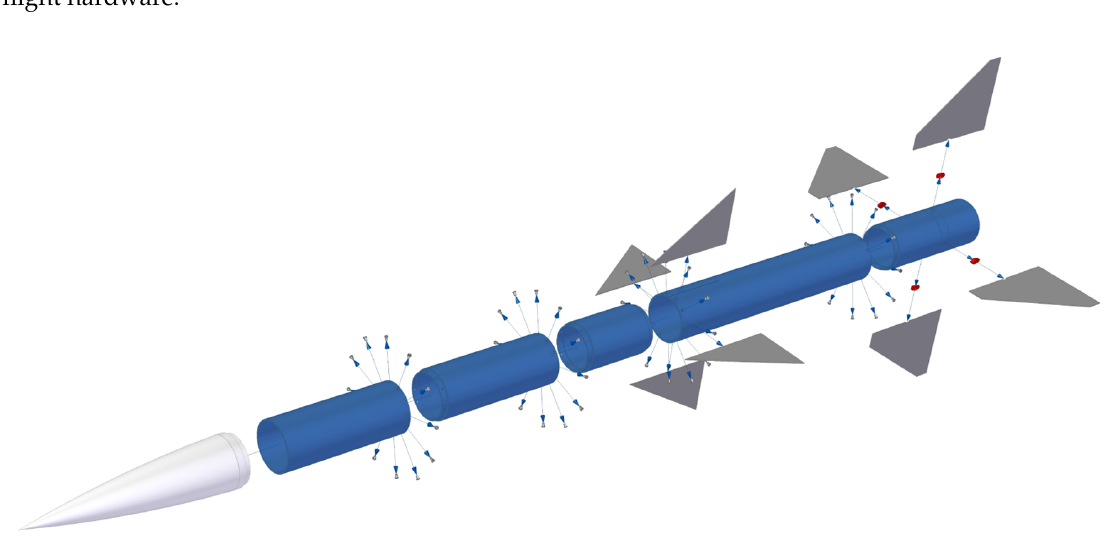
Figure 9. Exploded view: AIM-120 AMRAAM